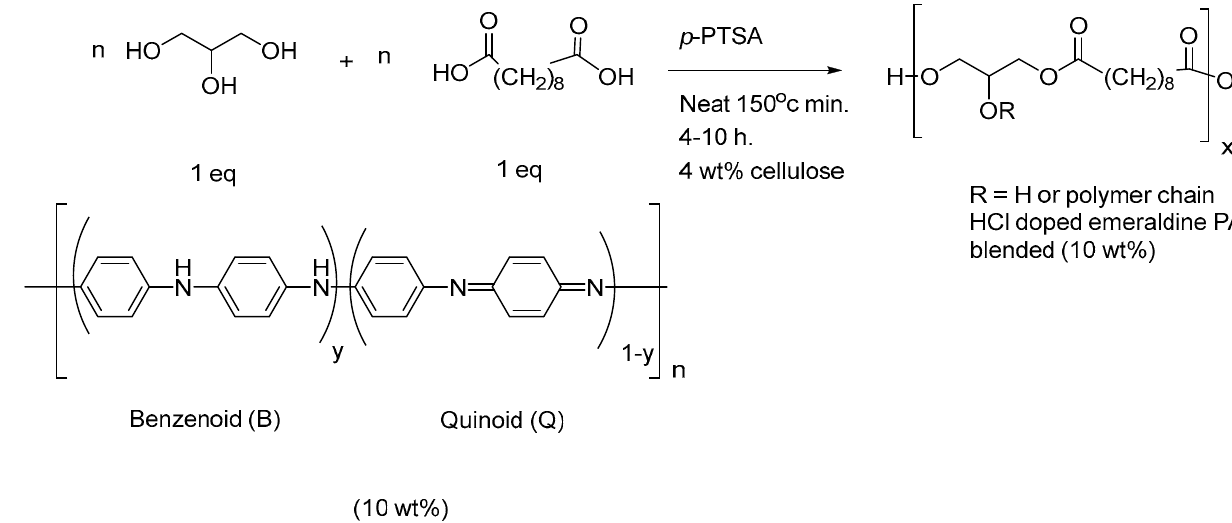
Figure 12. Global procedure for the production of robust PGS9 sheets containing 10 wt% emeraldine Figure 12. GlobalprocedurefortheproductionofrobustPGS9sheetscontaining10wt%emeraldine PANI.